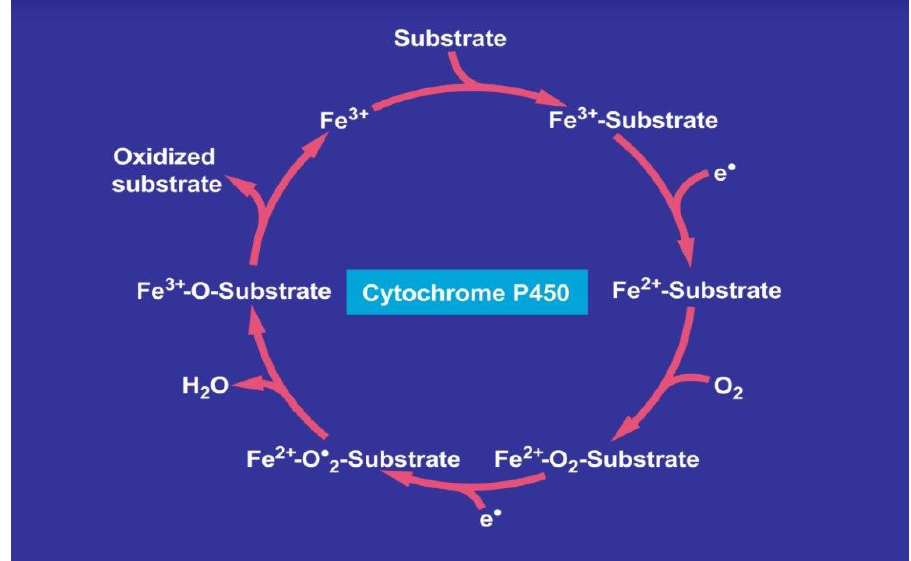
Figure 3. Catalytic CYP 2E1 cycle of MEOS. CYP reaction with Fe 2+ is generated; after splitting off the oxidized substrate (ethanol), Fe 2+ is oxidized again. CYP became then again free and is oxidized again.